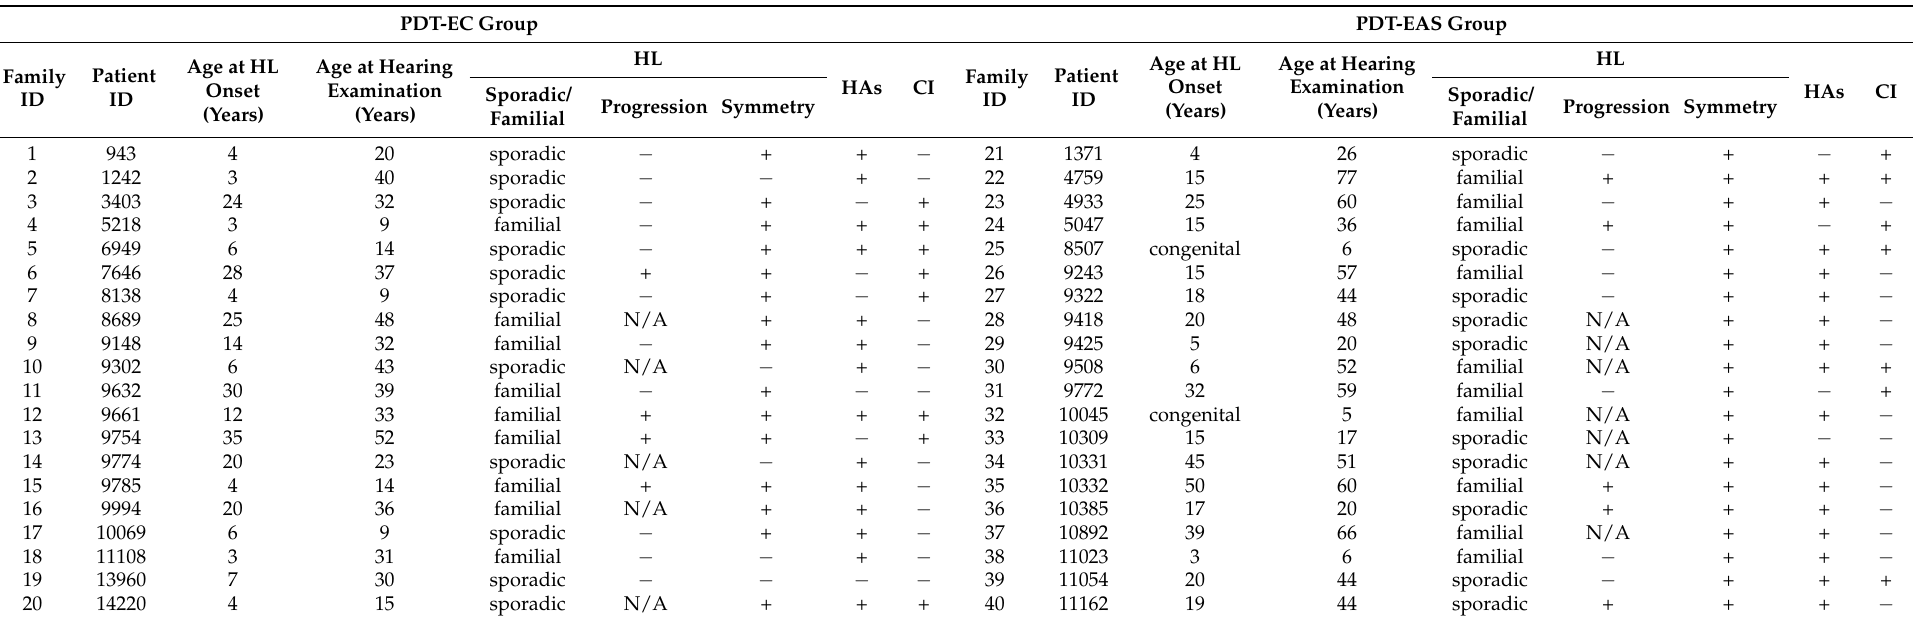
Table 1. Audiological characteristics of the PDT